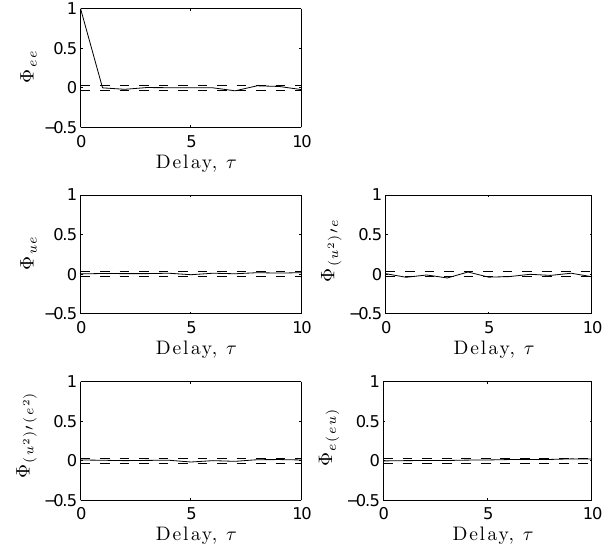
Fig. 2. Correlation tests for model validation of Eq.